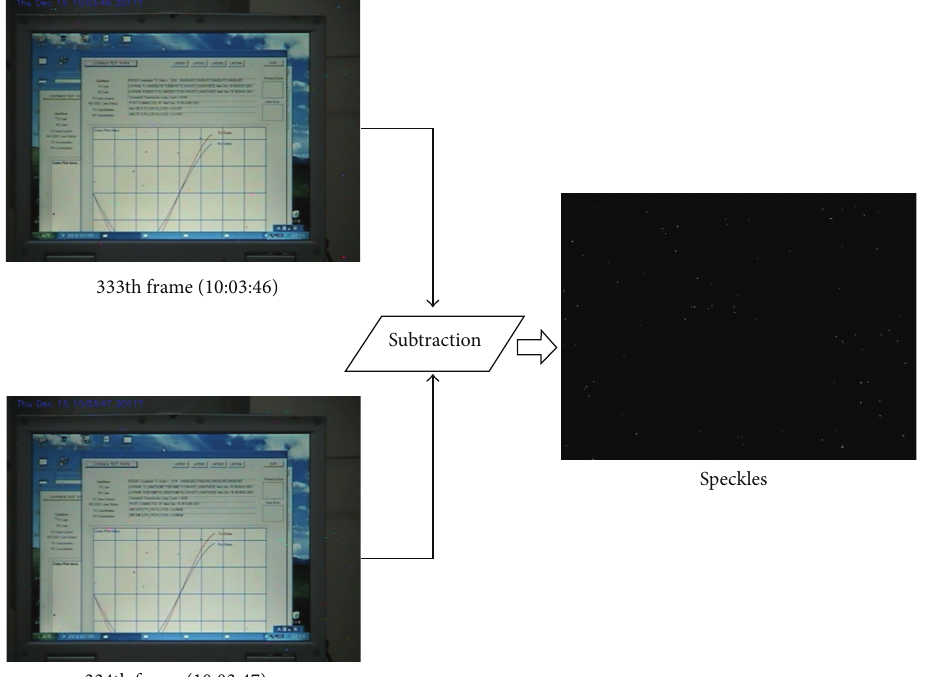
Figure 8: Speckle extraction using an image subtraction algorithm.